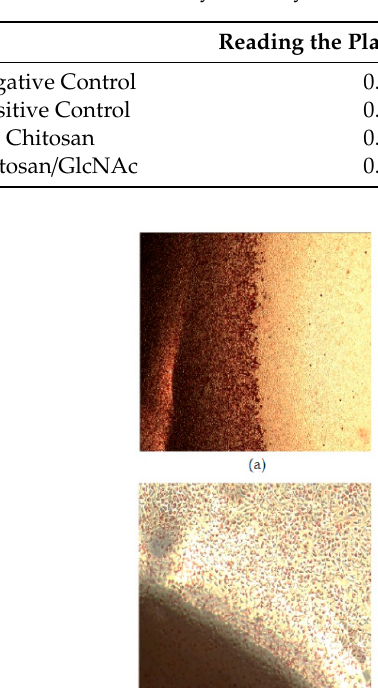
Table 4. Cytotoxicity assessment using the agar zone test.